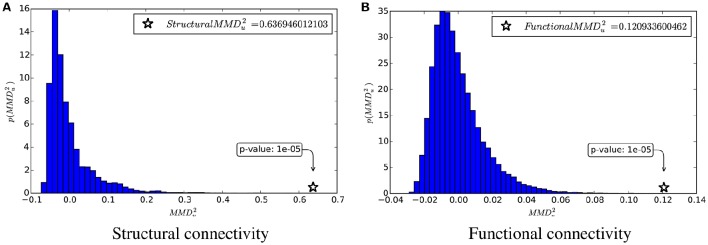
MMDu2 and the estimation of its null distribution. (A) Structural connectivity. (B) Functional connectivity.